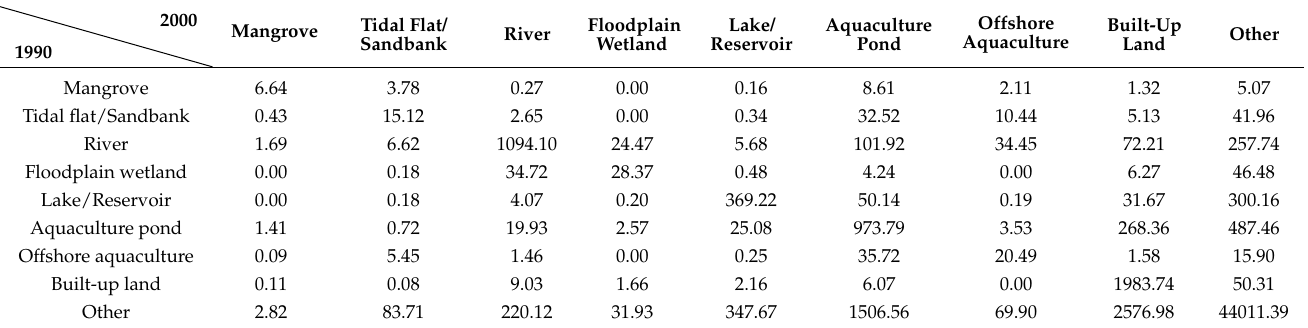
Table A2. Transfer matrix of each land cover type in the GBA from 1990 to 2000 (km 2